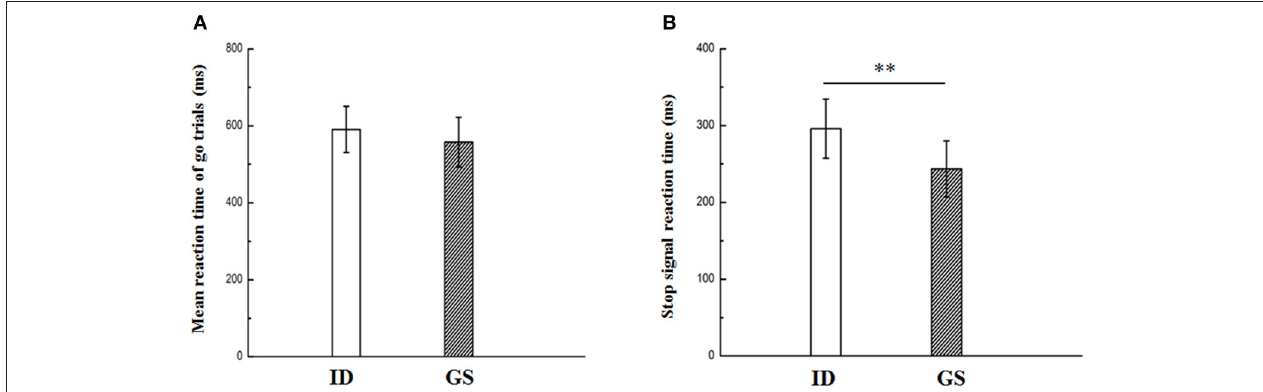
FIGURE 2 | Reaction time (Go RT, A ) in go trials and stop-signal reaction time (SSRT, B ) in patients with insomnia disorder (ID) and good sleepers (GS). ** Indicates significant level of p < 0.05.